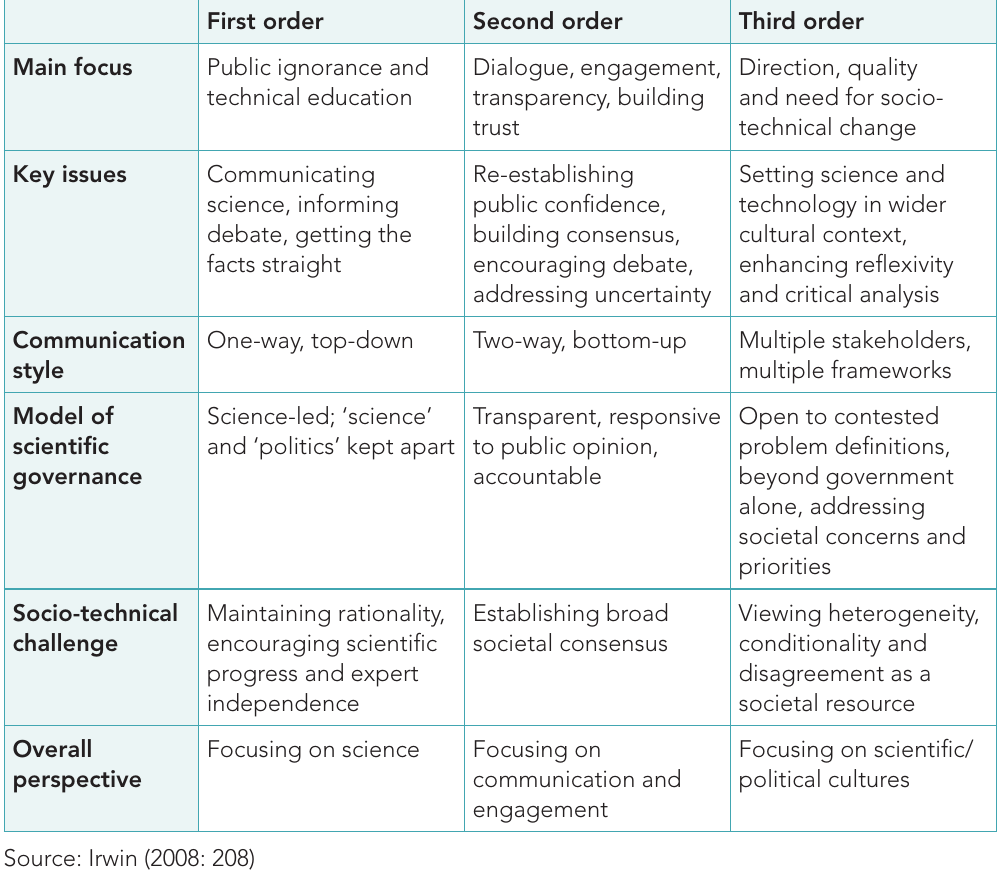
Table 1: Characteristics of first-, second- and third-order